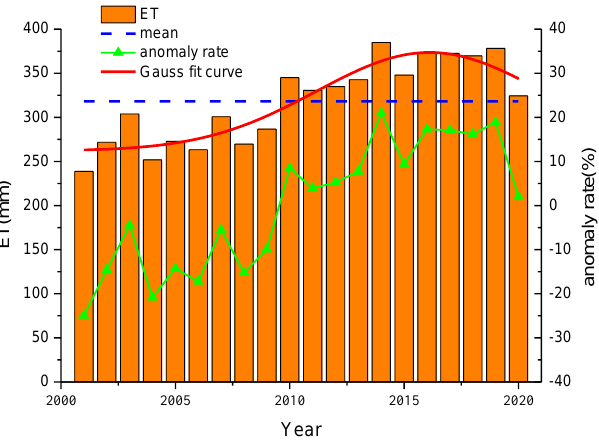
Figure 3. The trend of annual ET in Ningxia from 2001 to 2020.